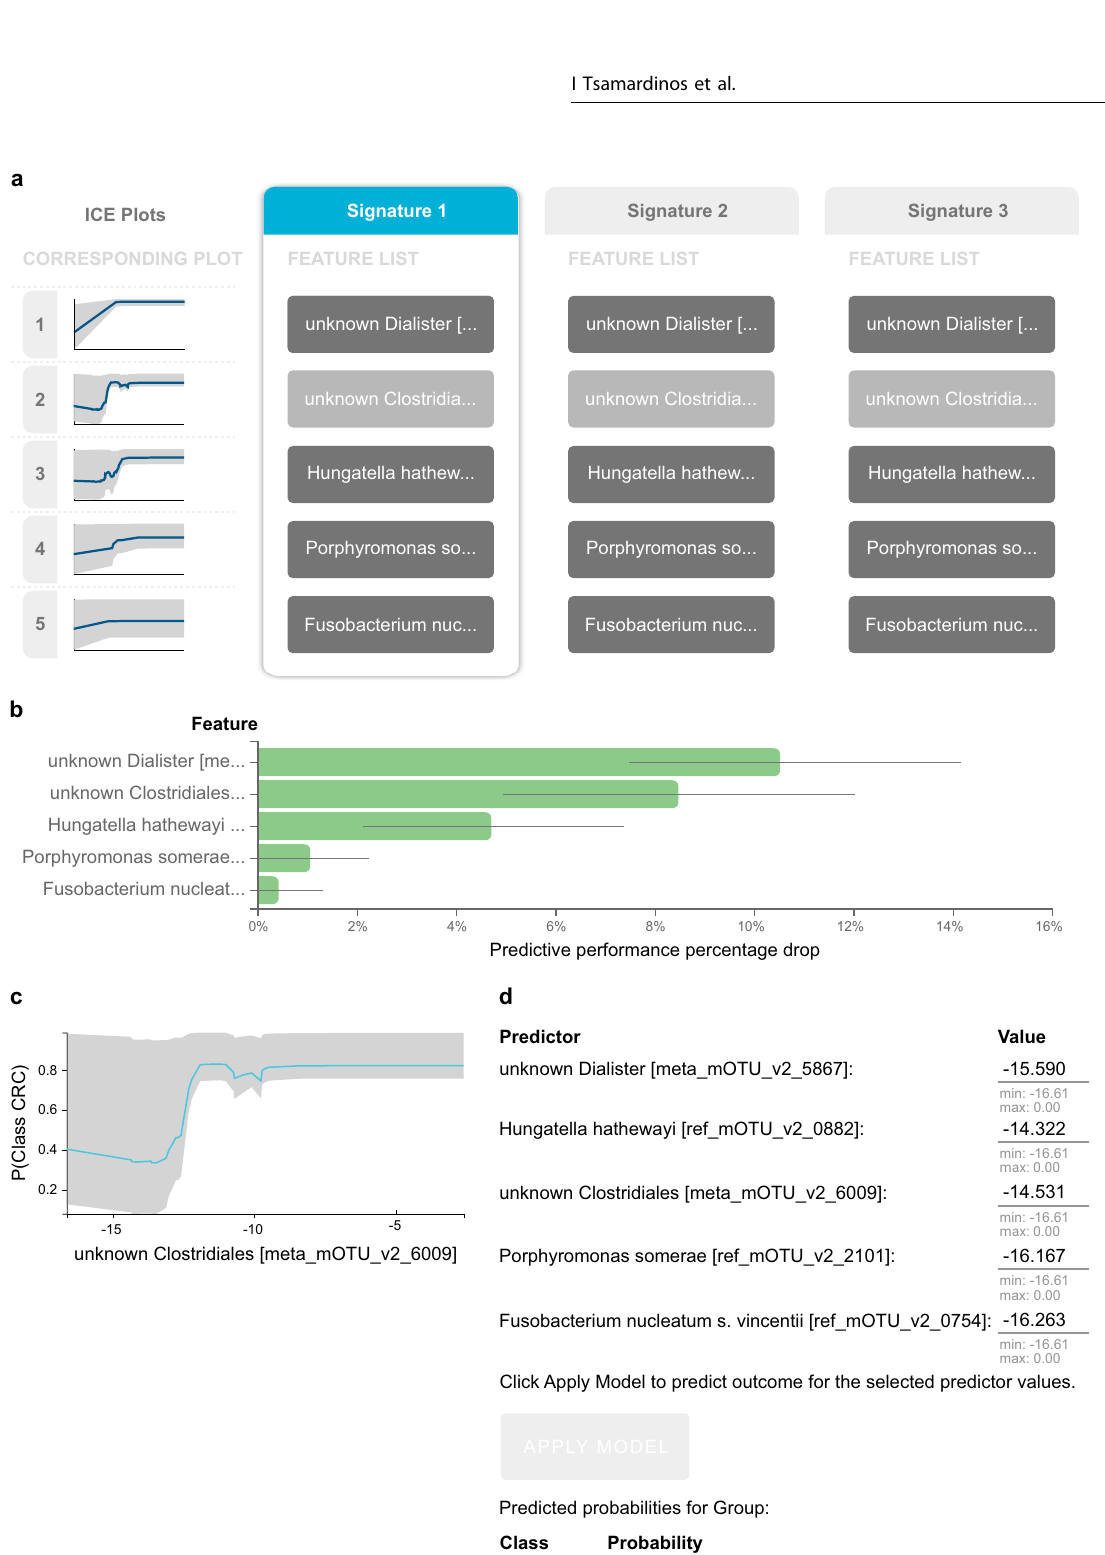
Fig. 3 Feature selection (biosignature discovery) results for the best-performing model using the France (FR) cohort as training data. a There are three biosignatures identi fi ed, each containing fi ve features. Each signature leads to an optimally predictive model. They share four features, while the second feature varies across signatures. b Feature importance plot, assessing the relative drop in performance if each feature is dropped from the signature and the rest are retained. c The Individual Conditional Expectation (ICE) plot for the ‘ unknown Clostridiales [meta_mOTU_v2_6009] ’ : the higher its abundance, the higher the probability of colorectal cancer. Note that the trend is non- linear and non-monotonic (close to step function). d The manual application of the model to get predictions for a fi ctional new sample is shown. Values are log-transformed relative concentrations, which can be negative if the original numbers are smaller than the logarithm